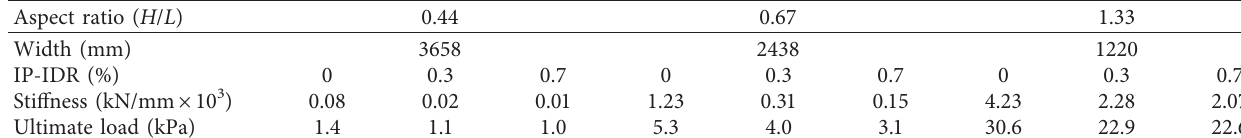
Figure 6: Sensitivity of structural response to modeling parameters. (a) Ultimate load. (b) Initial stiffness. Table 4: The information and analysis results of infill walls with different aspect